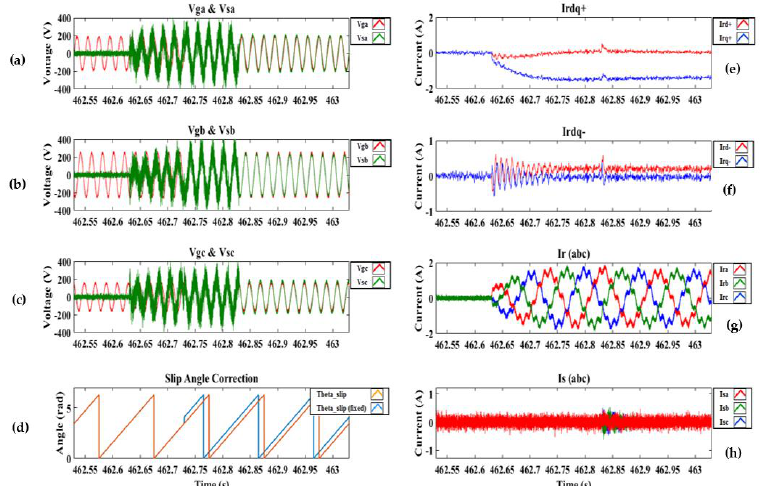
Figure 9. Experimental results for DFIG soft synchronization to the grid using proposed procedure. ( a ) Phase-A grid and stator voltages ( b ) Phase-B grid and stator voltages ( c ) Phase-C grid and stator voltages ( d ) Phase angles difference ( e ) Positive sequence rotor current components ( f ) Negative sequence rotor currents components ( g ) Three-phase Rotor currents ( h ) Three-phase Stator currents.